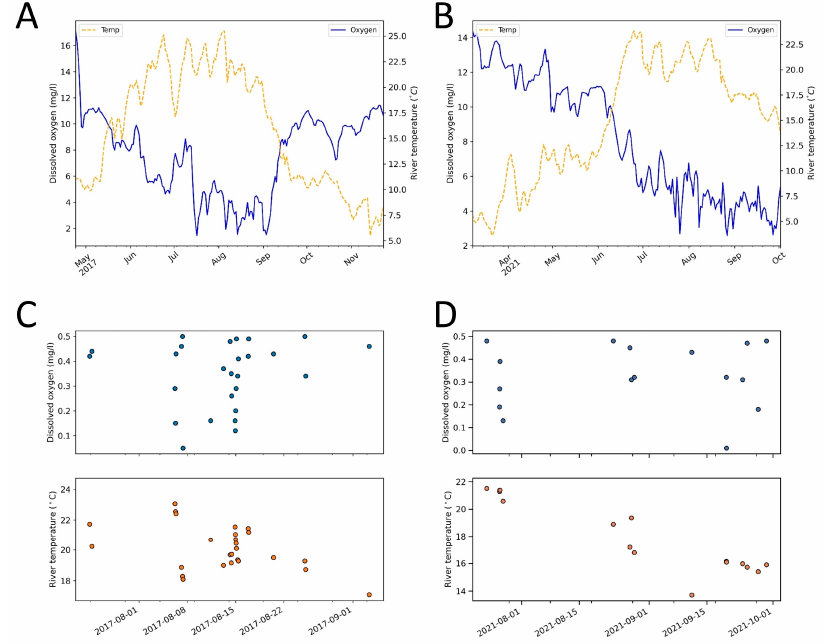
Figure 5. ( A , B ) DO data re-sampled as daily mean and ( C , D ) data points for DO < 0.5 mg/L and temperature of every 5th data point in 2017 and 2021, respectively.